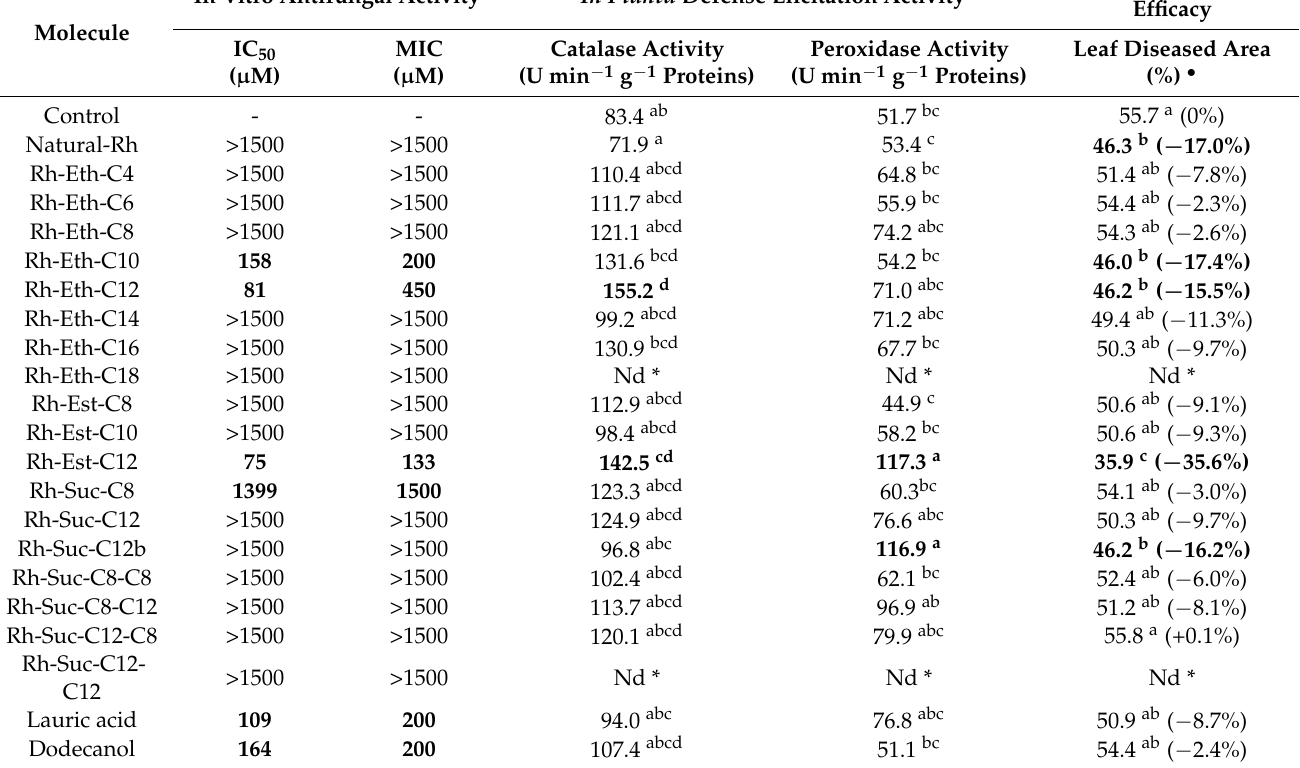
Table 3. Correlations between protection efficacy and both direct (IC 50 and MIC) and indirect (plant catalase and peroxidase activities) effects of the tested RLs, as well as dodecanol and lauric